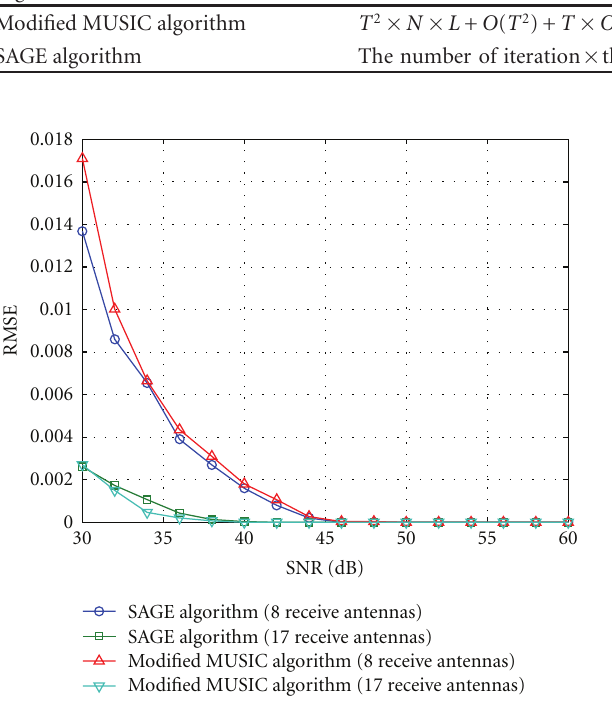
Figure 4: The RMSE of DOA estimation performance with Modi- fied MUSIC algorithm and SAGE algorithm in specular models.